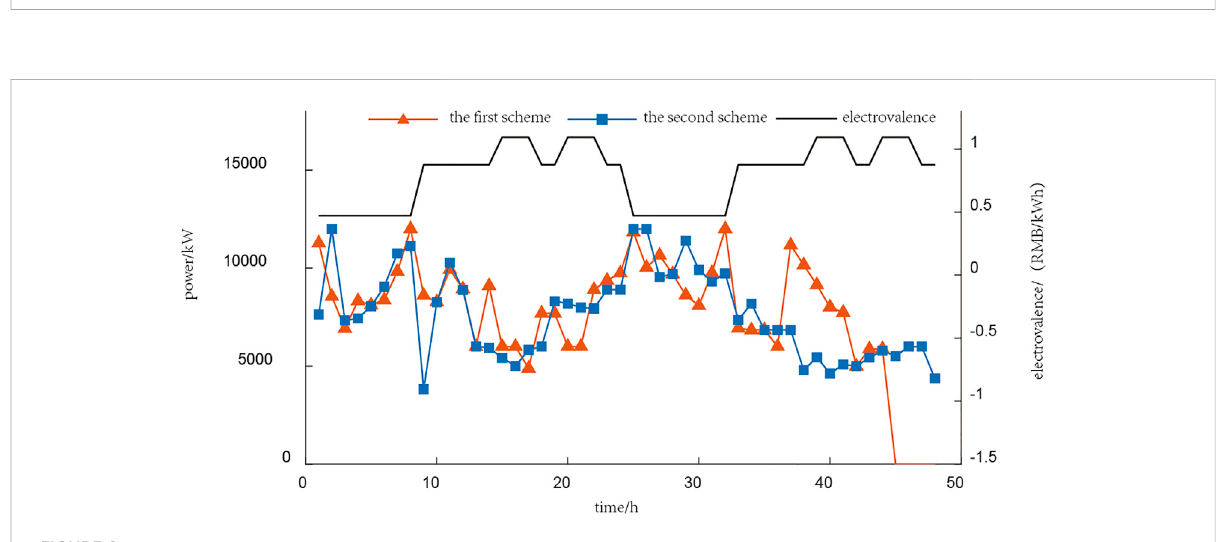
FIGURE 9 Comparation of ship load in two